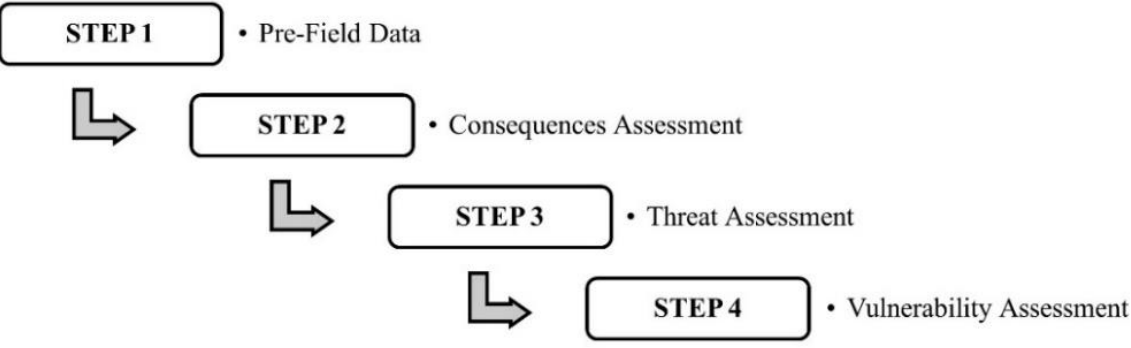
Figure 2. Assessment steps.